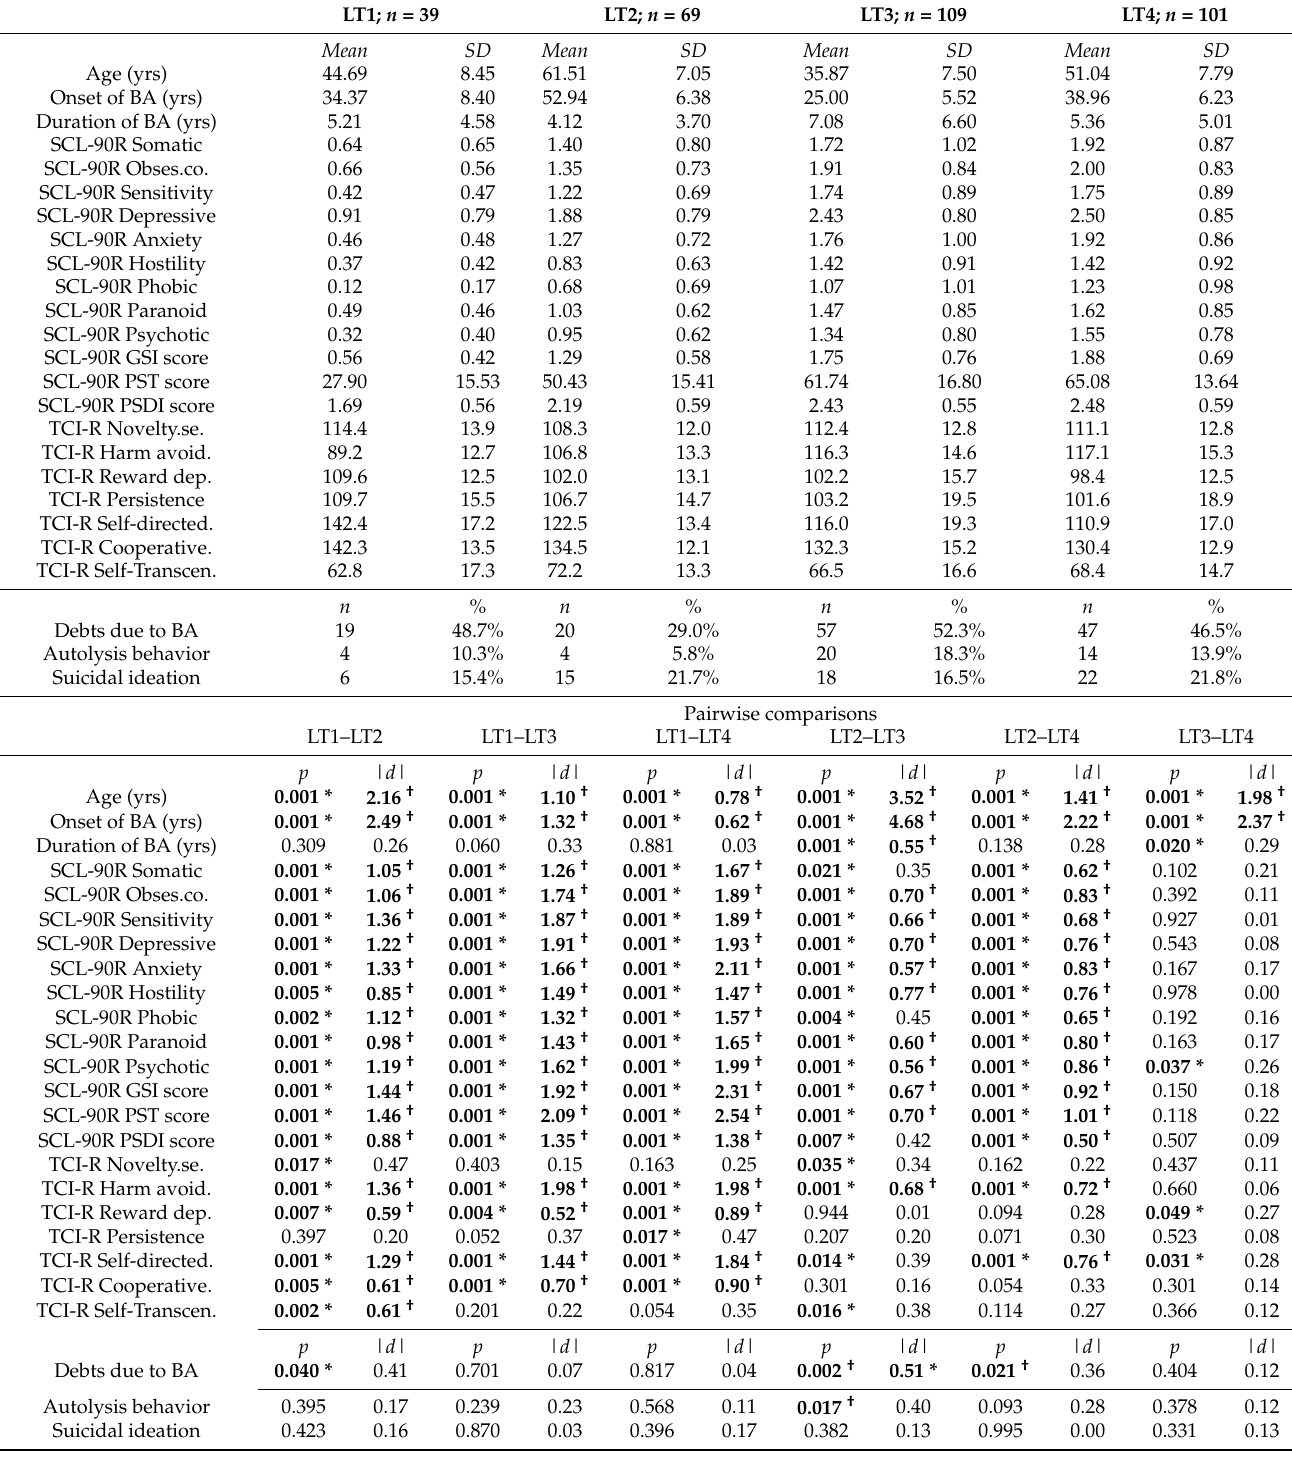
Table 5. Comparison between the latent classes for the clinical measures at